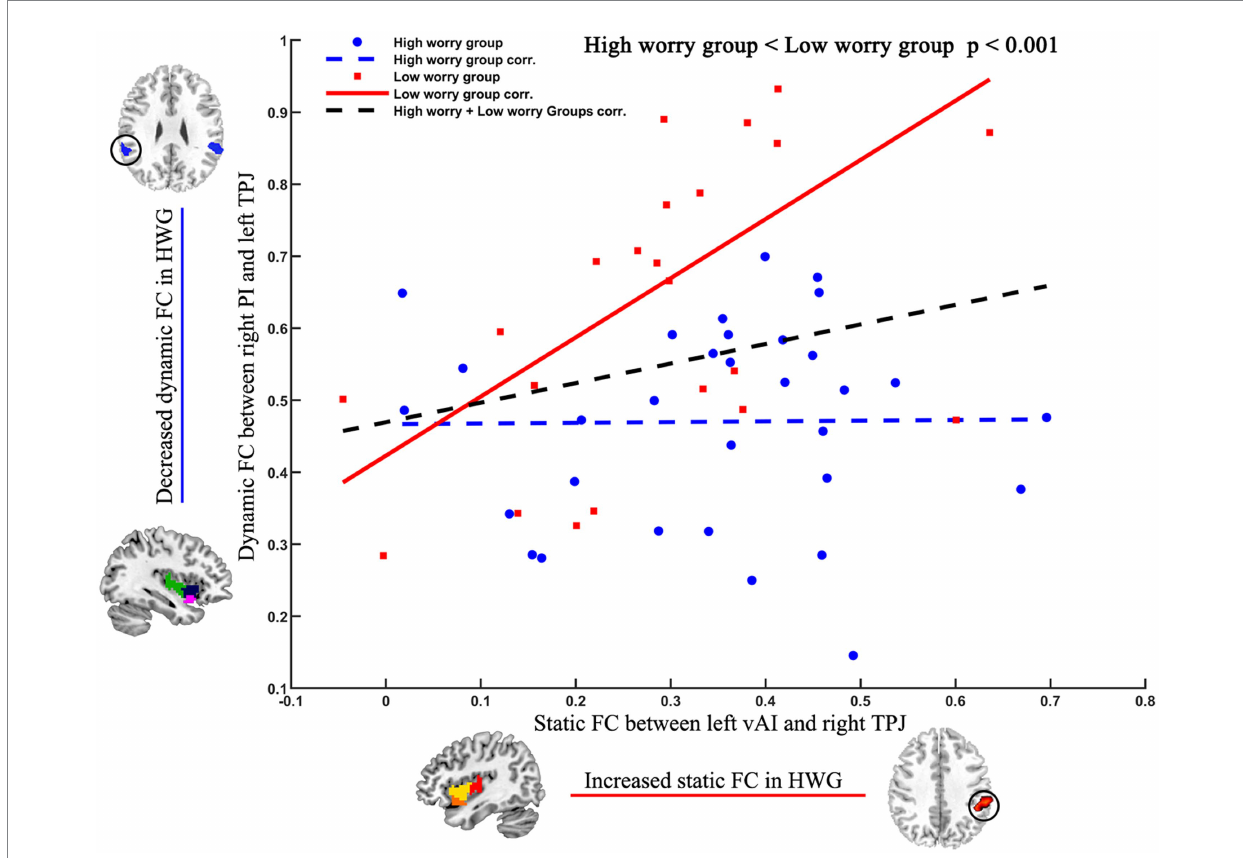
FIGURE 3 Different relationships between different FC of the posterior insula and changed FC of the anterior insula in two groups. Positive relationship ( r = 0.5728, p = 0.0028) between static FC (left vAI–right TPJ) and dynamic FC (right PI–left TPJ) in the low worry-proneness group (red node and line). Whereas this correlation ( r = 0.0113, p = 0.9512) was not apparent in the high worry-proneness group (blue node and line), the difference between these two correlation coefficients was significant ( p < 0.001).